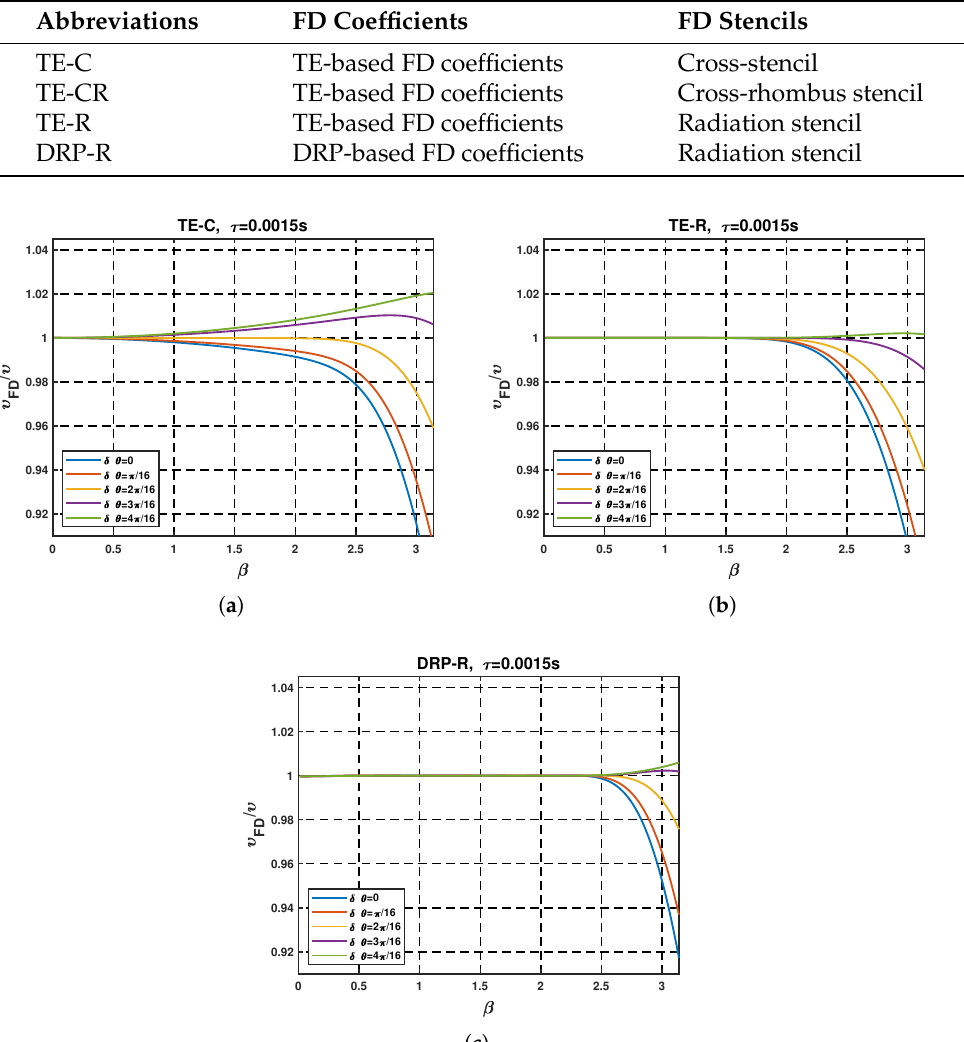
Figure 2. Dispersion curves varying with the parameters β = kh and propagation angle θ . Here, ∆ t = 0.0015 (s), υ = 1500 (m/s), h = 6 (m), M = 8, and N = 8: ( a ) TE-C method, ( b ) TE-R method and ( c ) DRP-R